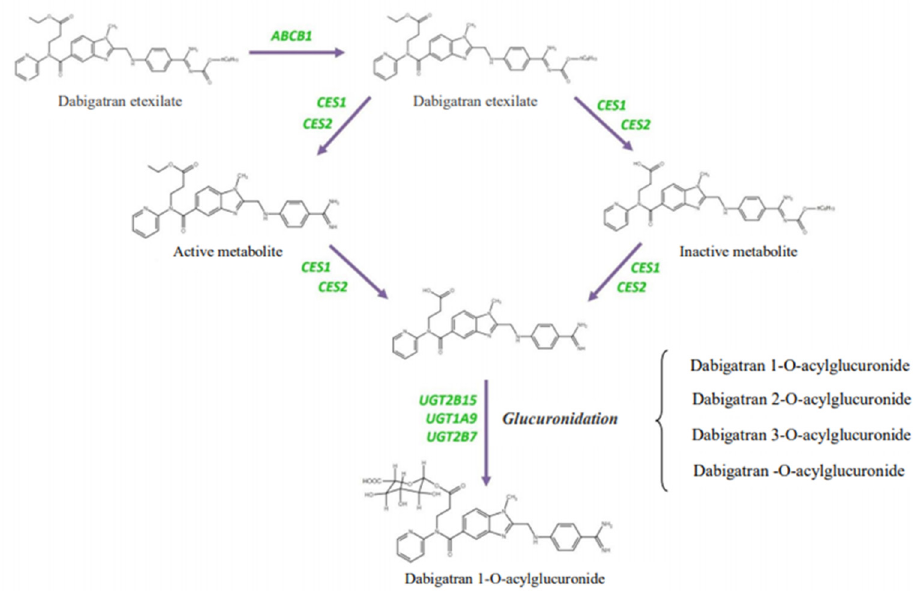
Figure 1. Genes involved in the metabolism of dabigatran etexilate [32] .